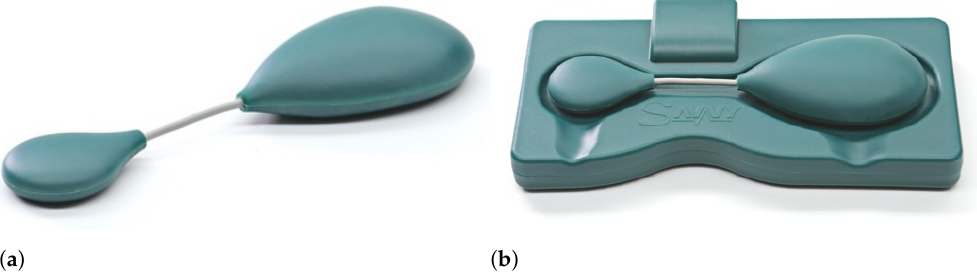
Figure 1. ( a ) Commercial version of the ECG body sensor. ( b ) The sensor placed on the charging